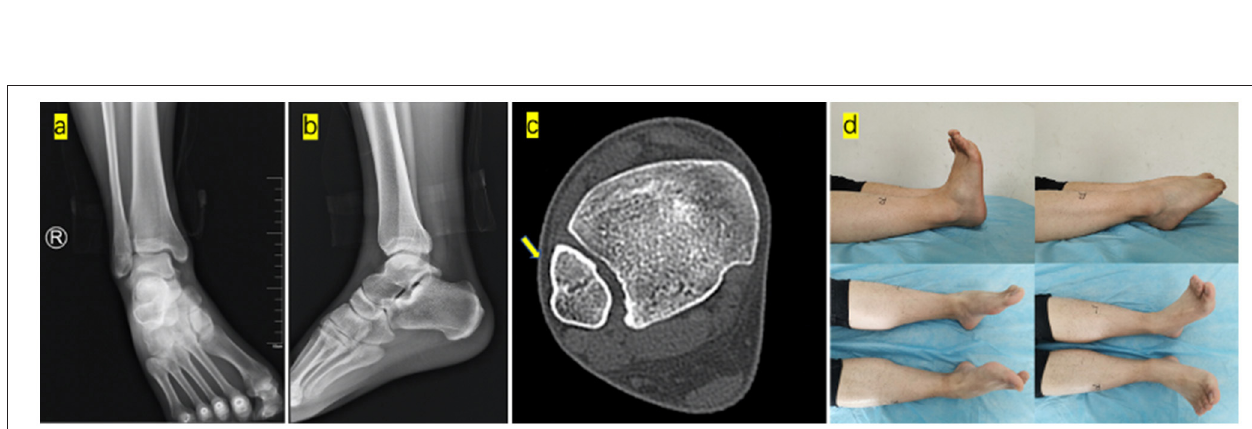
FIGURE 2 | Post-manipulative radiographs show the anatomical alignment of the ankle mortise following closed reduction and external fixation. Anteroposterior (a) and lateral (b) . Post-manipulative CT showed normal tibiofibular syndesmosis (yellow arrow). CT axial scans (c) and 3D CT (d) .